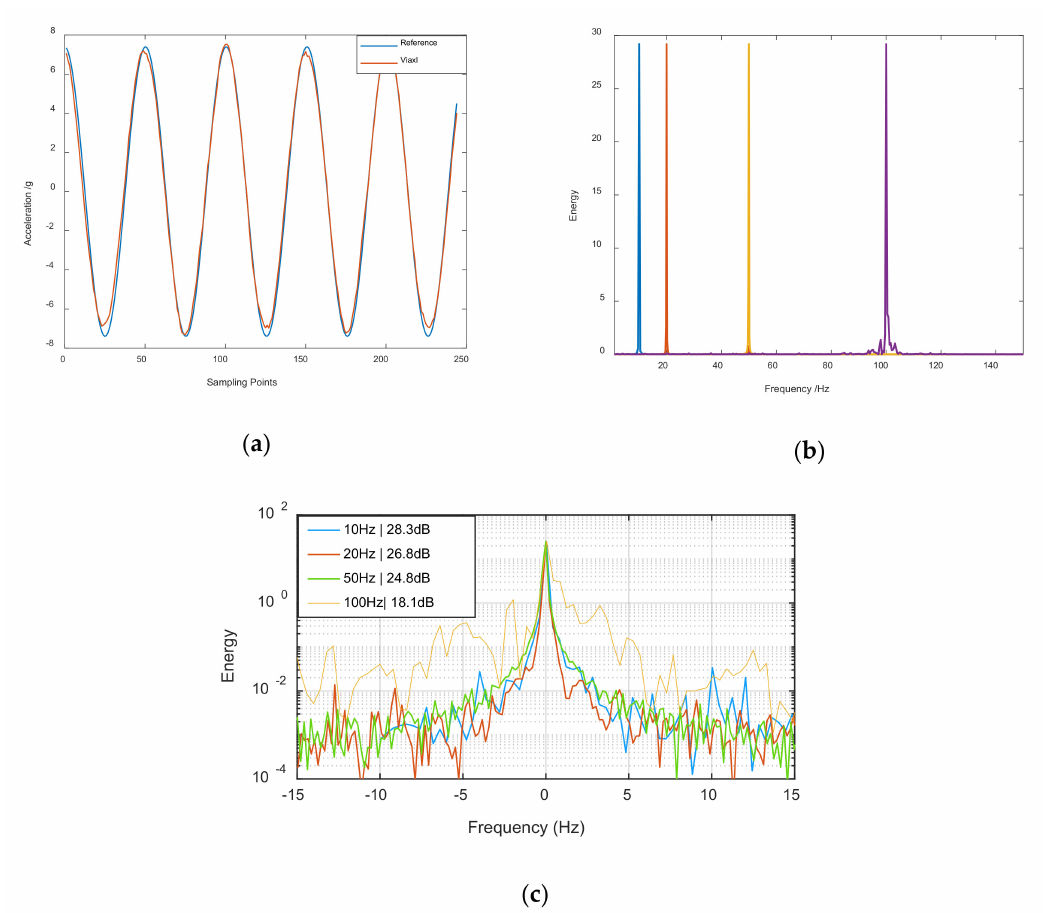
Figure 6. Accuracy of Viaxl’s results: ( a ) Comparison between the setting value of the platform and Viaxl’s result at 20 Hz; ( b ) spectra of 10–100 Hz Viaxl measurements; ( c ) comparison of power spectral density under di ff erent measurement frequencies (the abscissa is the di ff erence between the actual vibration frequency and the measured vibration